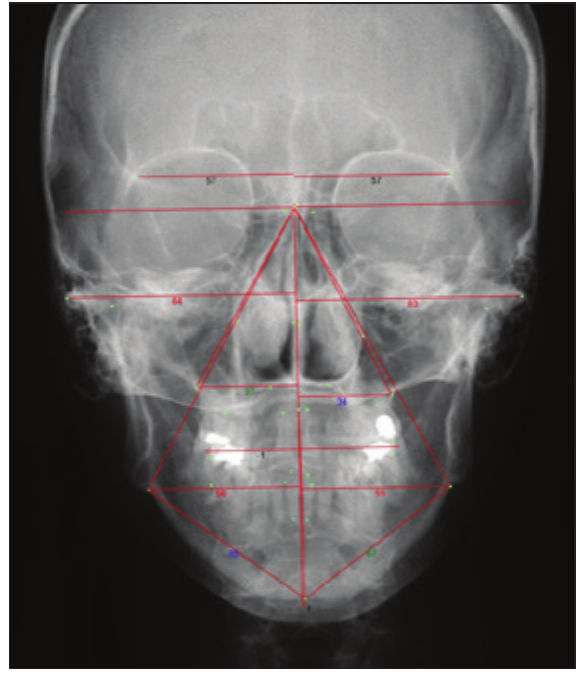
Figure 13. Lateral cephalometric radiograph of the patient after 10 years follow-up.